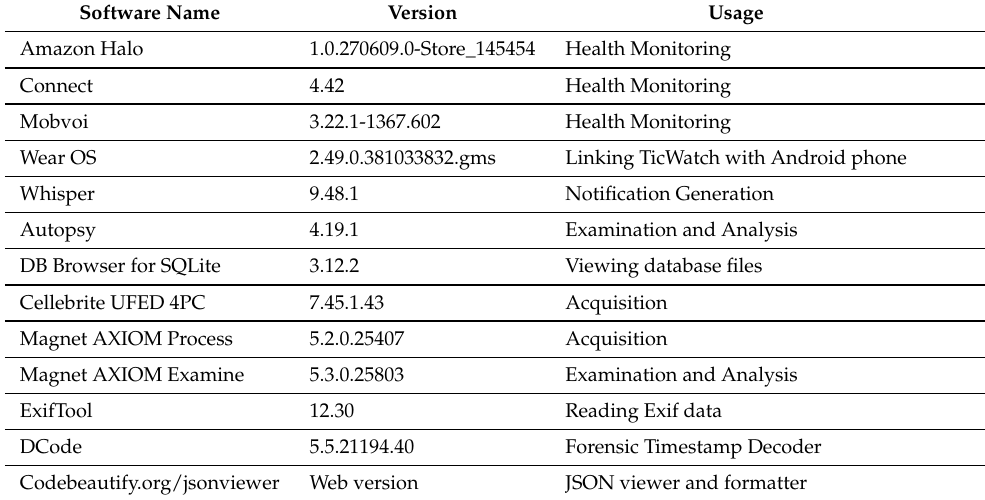
Table 4. Applications and tools used in this